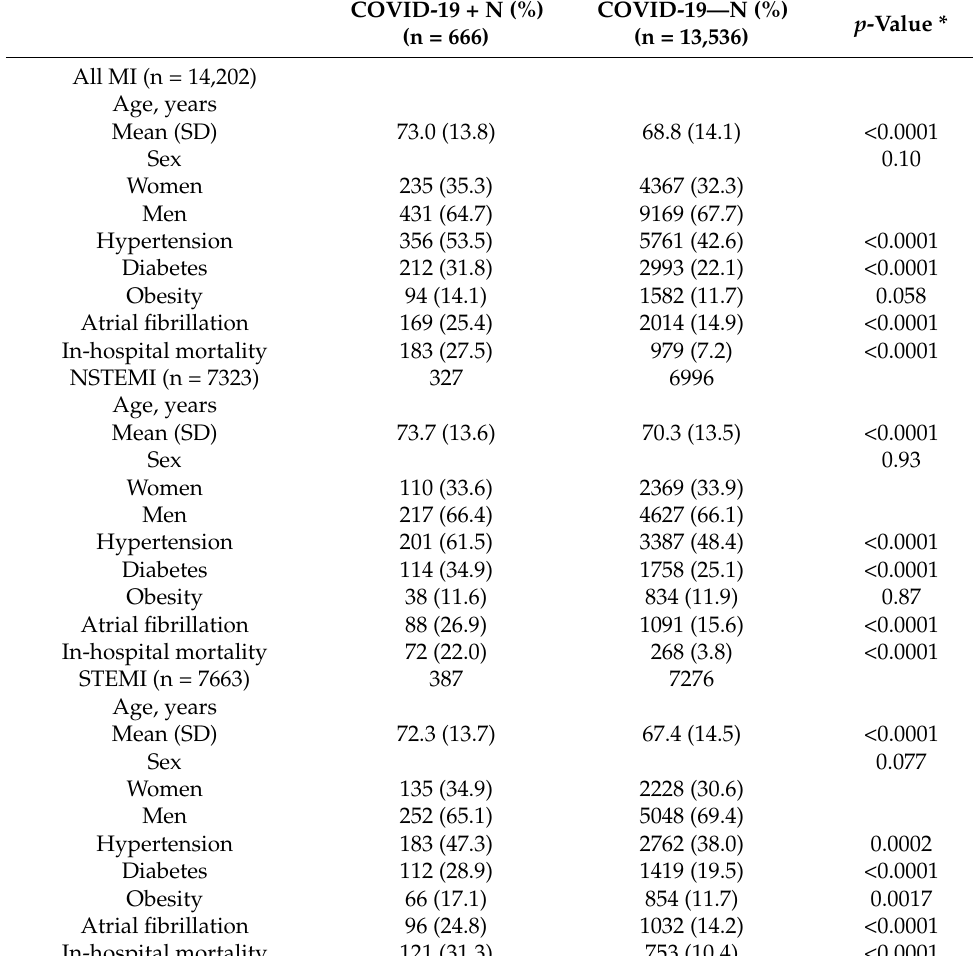
Table 1. Clinical characteristics of myocardial infarctions among COVID-19 vs. non-COVID-19 patients during the lockdown of